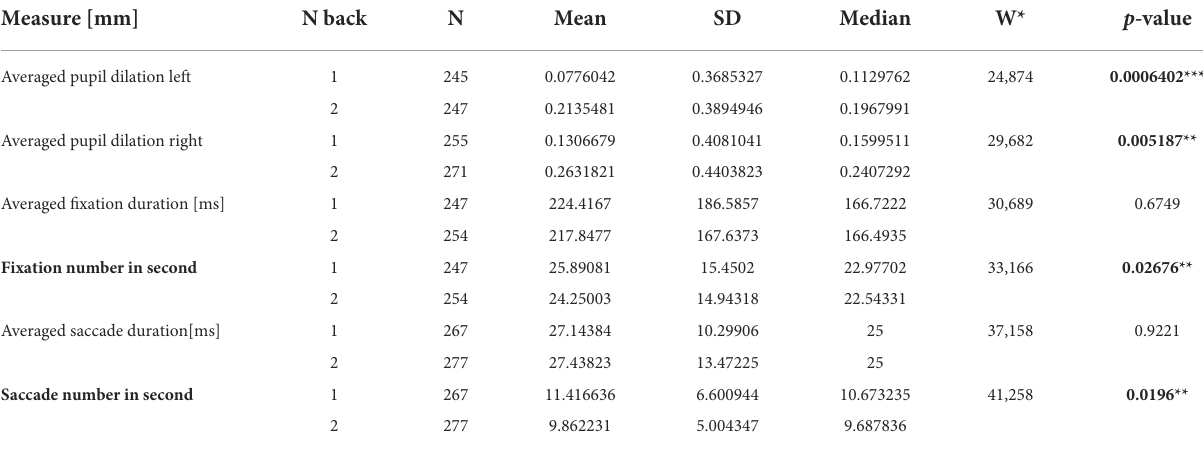
TABLE 5 The descriptive statistics and Mann–Whitney–Wilcoxon test results for the averaged pupil dilation left, the averaged pupil dilation right, the averaged fixation duration, the averaged fixation number, the averaged saccade duration, and the averaged saccade number in second between 1 and 2 back.